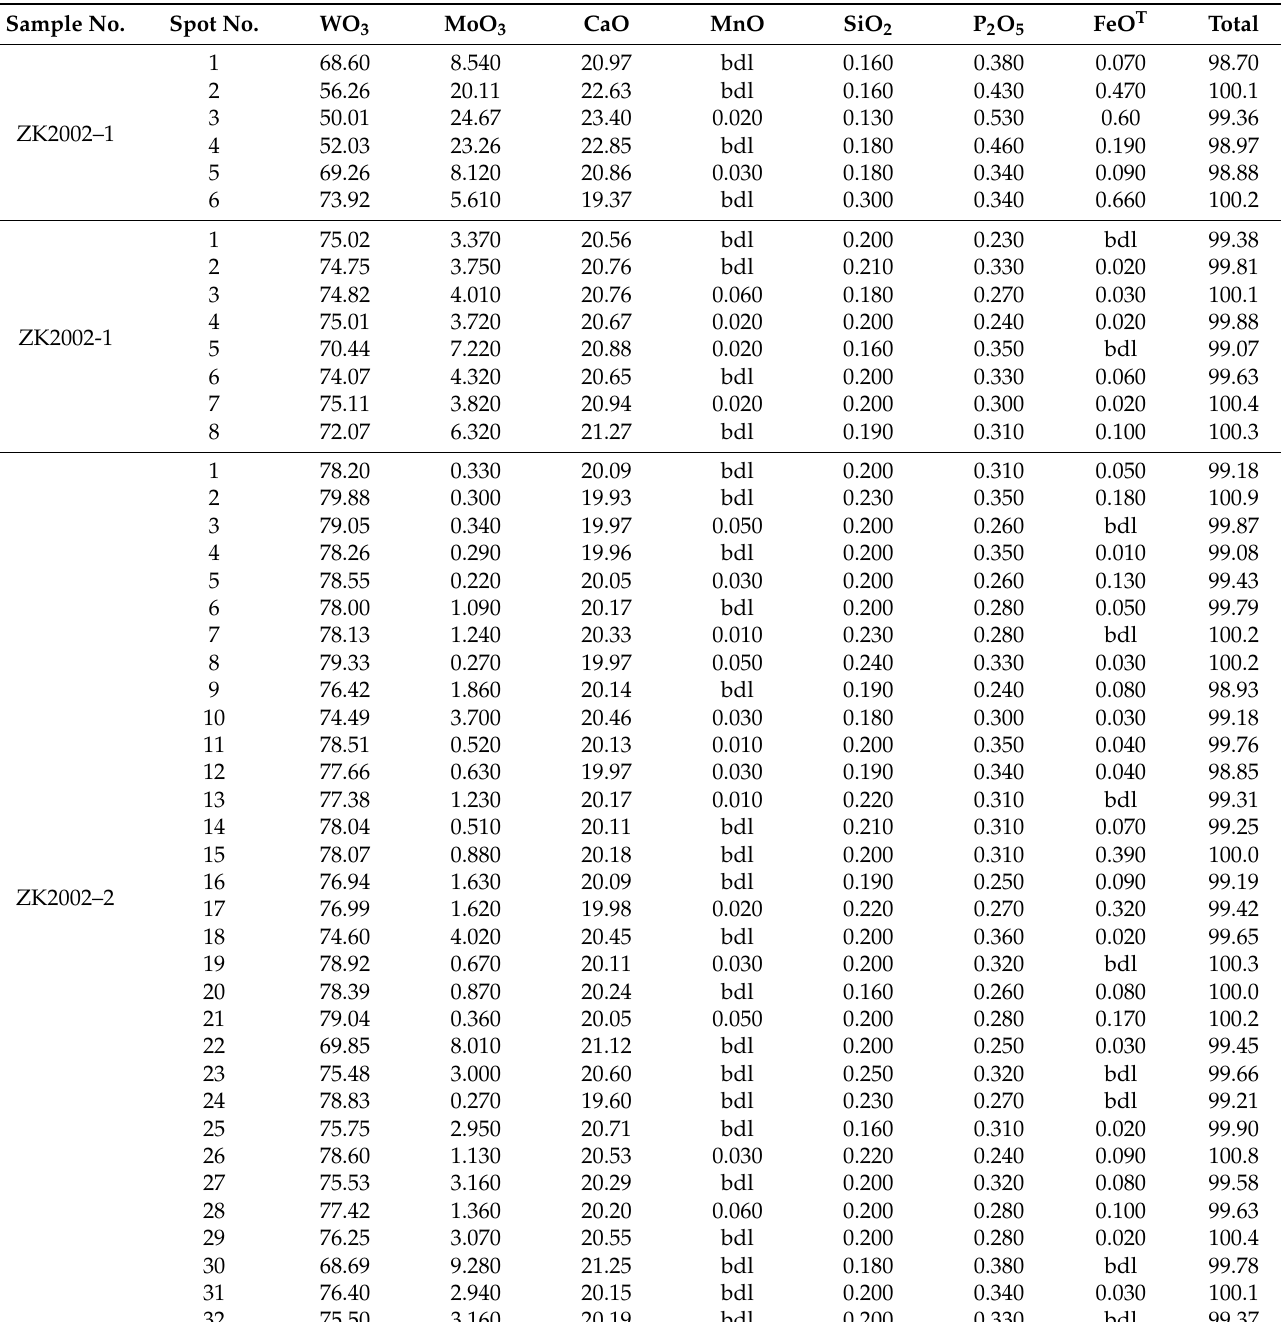
Table 1. Results of major element analysis in scheelite from the Tongshankou deposit (wt.%). Sample